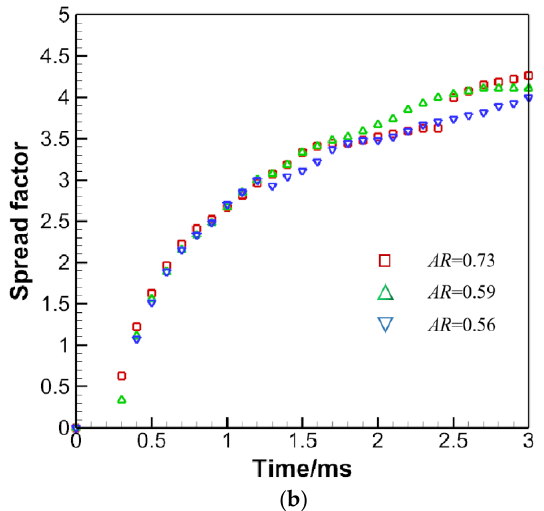
Figure 13. ( a ) Spread factor evolution for the oblate droplet impact in the transverse direction. ( b ) Spread factor evolution for the oblate droplet impact in the longitudinal direction. Upper is for the transverse direction, with the largest spread factor of around 3.4. The larger the AR, the bigger the spread factor. For the longitudinal direction, larger ARs lead to bigger spread factors as well. The maximal spread factor comes bigger in the longitudinal direction as expected, as demonstrated in Figure 14, which is drawn on the same scale, with the black solid line denoting 0.7 ms, the red 1.7 ms and the blue 2.9 ms. Besides, the sudden jump in the spread factor may be ascribed to the formation of fingers or the jetting of smaller droplets along the axis where the spread factor is tracked.